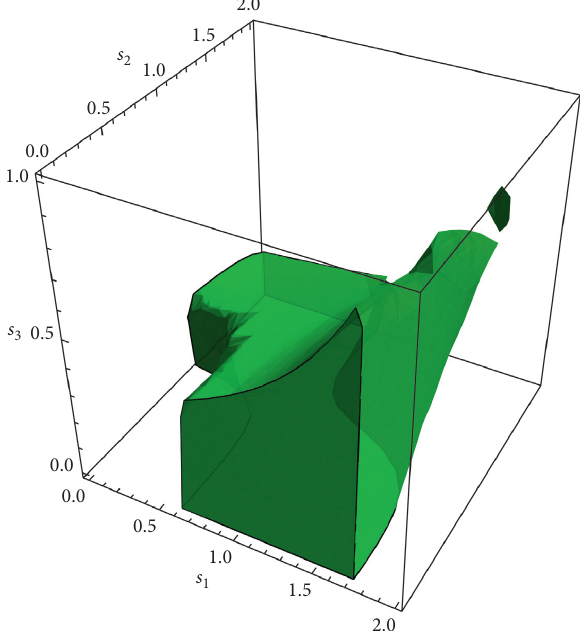
Figure 7: Controllable region (green) for system